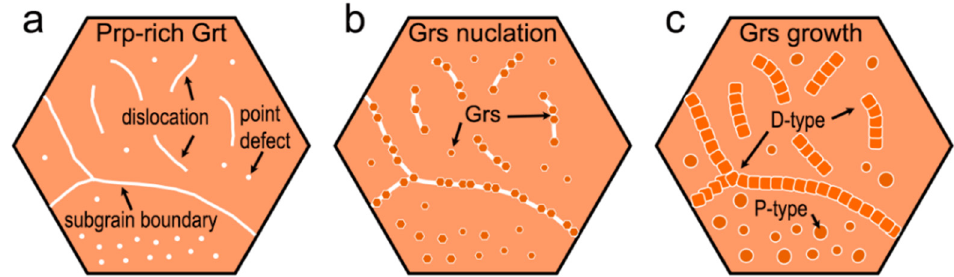
Figure 8. Schematic diagram of Grs-rich lamellae precipitated at the crystal defects of Prp-rich garnet. ( a ) Point defect and dislocation as well as its substructure (subgrain boundary) in Prp-rich garnet. ( b , c ) Grs-rich lamellae heterogeneously nucleate and grow at point defects (P-type, shown as Cressey [19] and Wang et al. [20]) and dislocations or subgrain boundaries (D-type, this study).